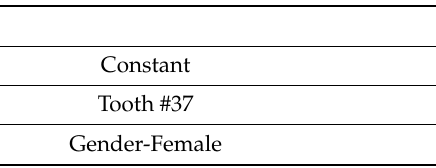
Table 3. Stepwise linear regression